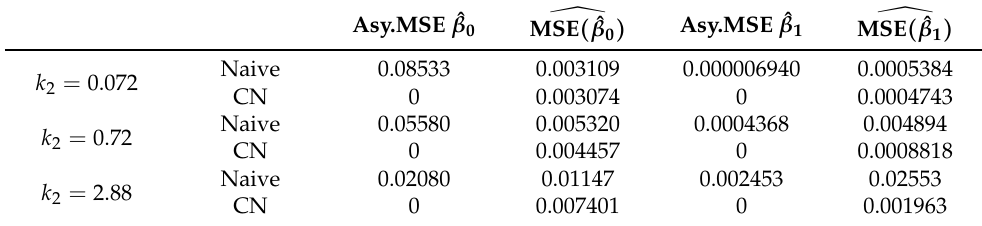
Table 4. Estimated MSE of a Gamma distribution with a Gamma error.